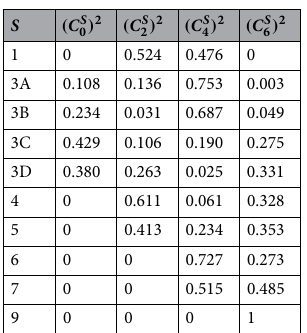
S ) 2 for the eigen-spin-states of the 3-body system. 3A to 3D are for η